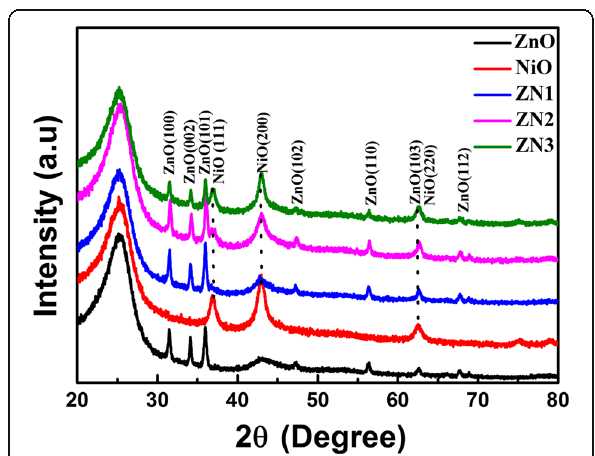
Fig. 2 XRD patterns of ZnO, NiO, and ZnO@NiO composites